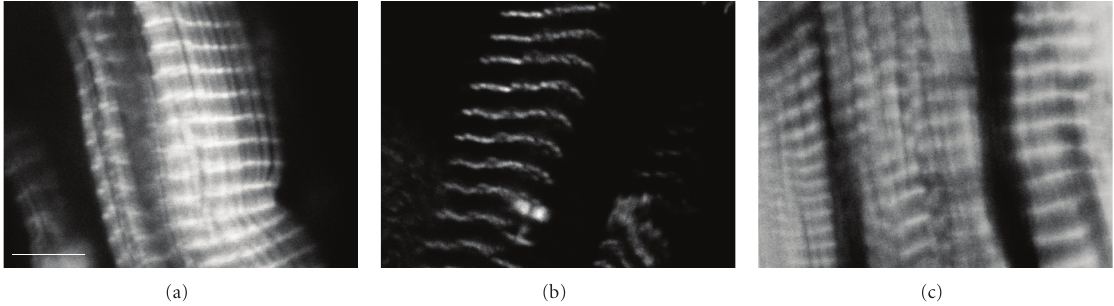
Figure 2: Confocal fluorescent micrograph of muscle fibers at each step of thin filament removal and reconstitution. (a) Control cardiac muscle fibers. (b) Gelsolin-treated muscle fibers. (c) Actin-filament-reconstituted muscle fibers. Actin filament was stained with rhodamine- phalloidin. Scale bar: 5 μ